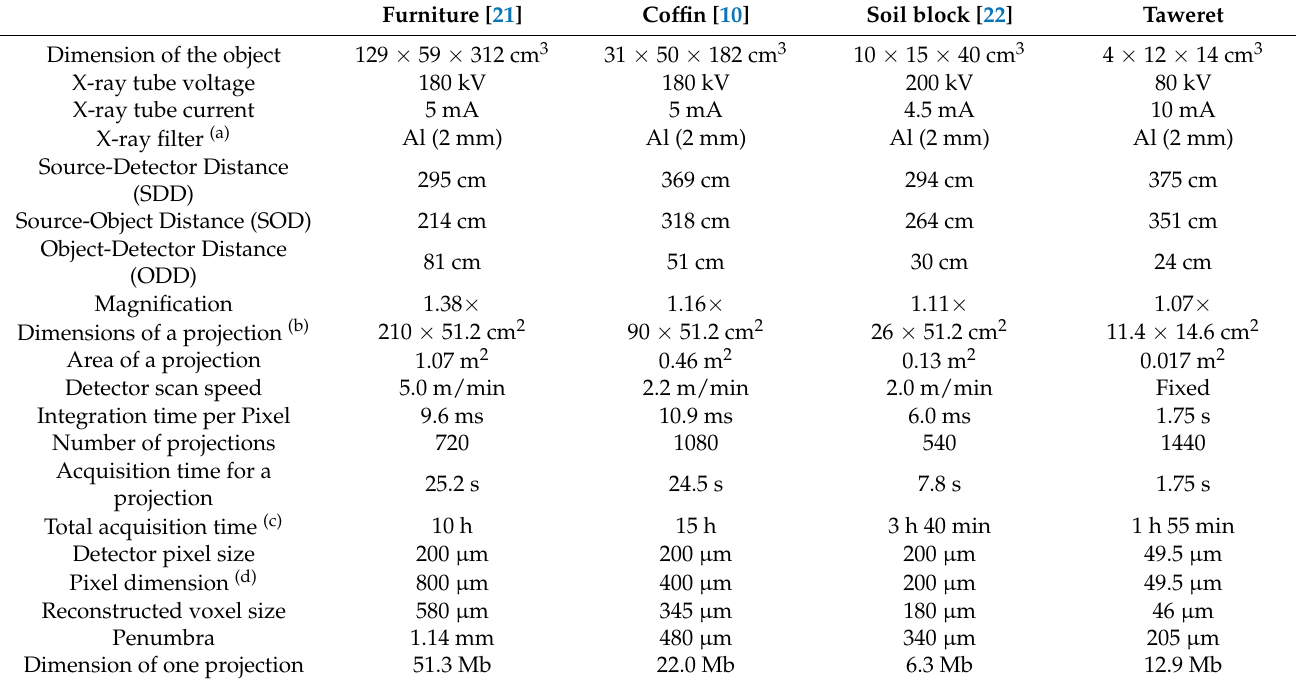
Table 2. Experimental CT